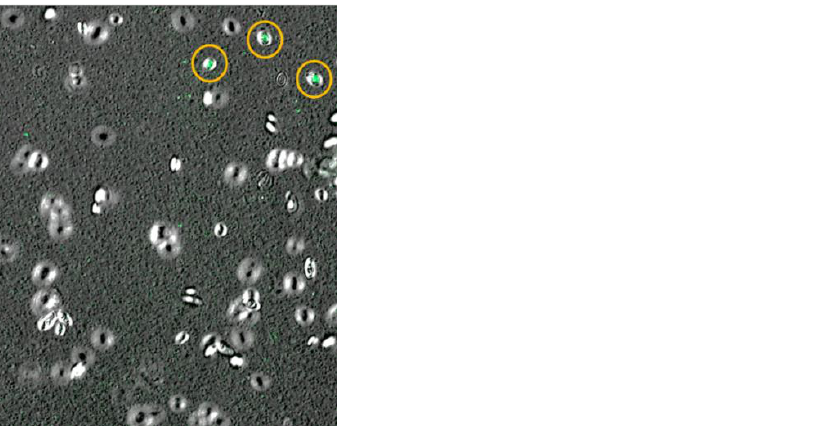
Table 3. Ferulic acid (FA), dimers of FA (di-FA) and trimer of FA (tri-FA) contents in SBWP/AX microbeads before (0 min) and after (120 min) laccase exposure.